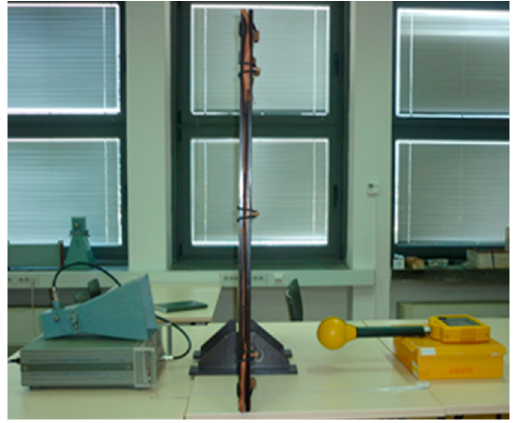
Figure 2. Measurement setup for the SE protective properties of textiles.